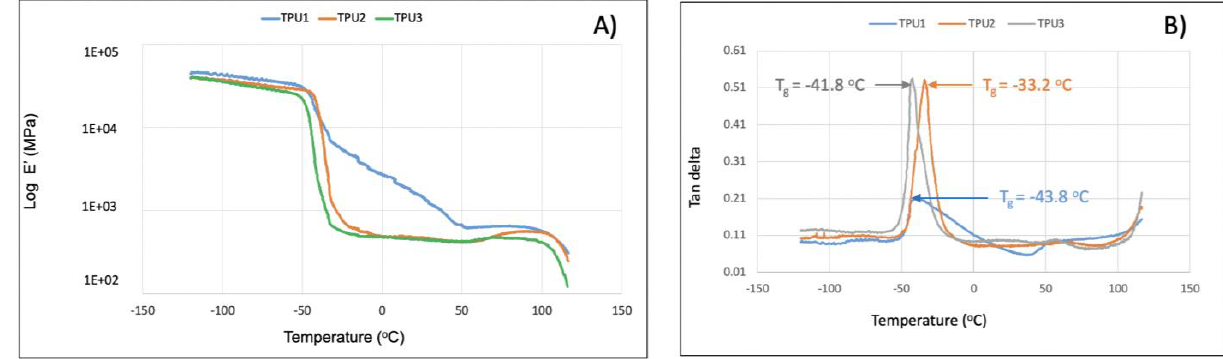
Figure 9. Stress – strain curve for TPUs. 3. Materials and Methods 3.1. Materials Azelaic acid (Crodacid DC1195, 100% bio-based) with 95% purity was supplied by Croda Inc. The 1,3-propanediol (bio-based) was obtained from Susterra and used as re- ceived for polyol and TPU preparations. The 2-methyl 1, 3-propanediol was received from Sigma Aldrich and used without further purifications. The bio-based 3-methyl 1, 5-pen- tanediol was obtained from Visolis as a gift sample and used as such without purifica- tions. The dibutyltin dilaurate catalyst (DBTDL, 95%) was purchased from Sigma-Aldrich and used without purification. Hexamethylene diisocyanate (6HDI, 98%) was supplied by Alfa Aesar and used without purification for TPU synthesis. Sigma-Aldrich supplied 1.0 M tetrabutylammonium hydroxide in methanol and p -toluenesulfonyl isocyanate (96%) for hydroxyl number and acid number titration. HPLC grade toluene, 2-propanol acetoni- trile, reagent grade 1-octanol, and potassium hydroxide were supplied by Fisher Chemical for hydroxyl and acid number analysis. 3.2. Measurements FTIR analysis was carried out on a Perkin Elmer Spectrum X fitted with a ZnSe 1 mm ATR cell. Sixteen scans were taken at 1.0 cm −1 resolution. Proton NMR and carbon NMR